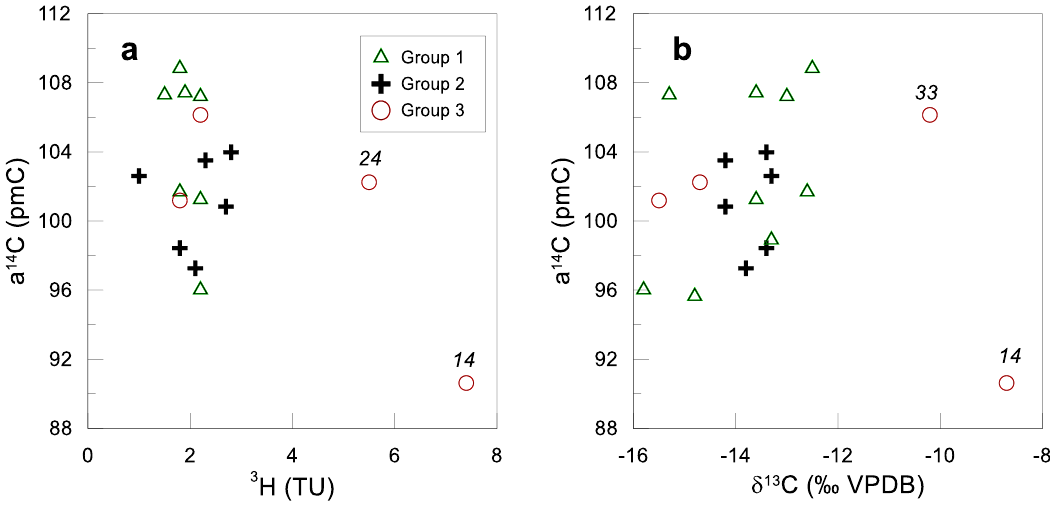
Figure 10. Isotope relationships: ( a ) 14 C vs. 3 H; ( b ) 14 C vs. 13C.